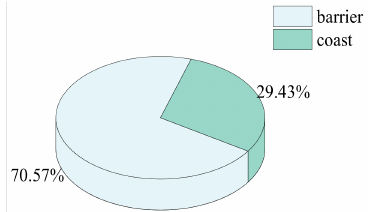
Figure 6. Proportion of various labels.